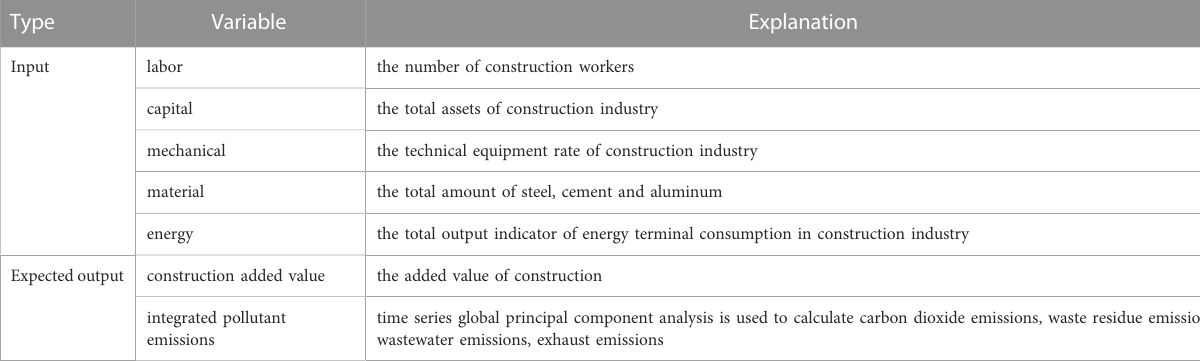
TABLE 1 Indicators for measuring the green development quality of the construction industry.